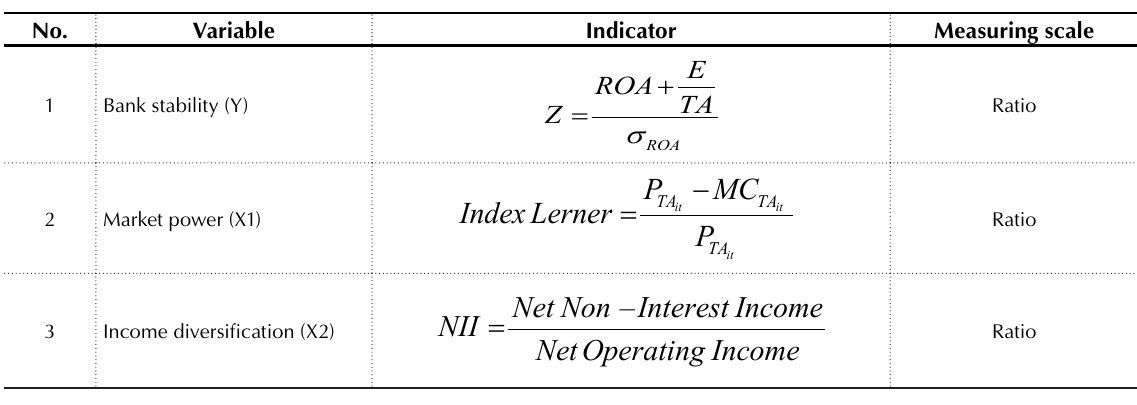
Table 1. Definitions and measurements of research